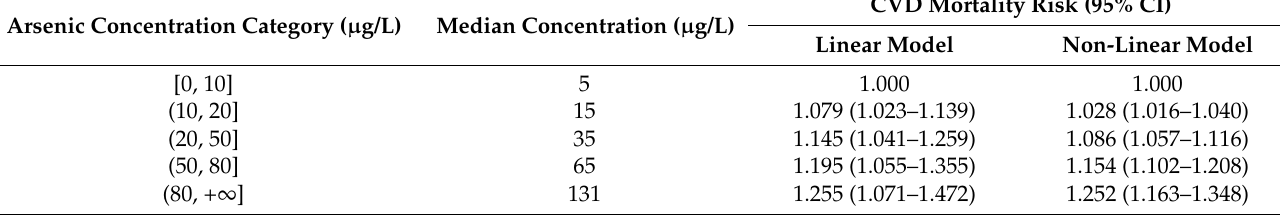
Table 1. Dose–response relationships between cardiovascular disease mortality and arsenic concentration in drinking water. Pooled relative risks (95% CIs) for cardiovascular disease (CVDs) mortality for the median concentration in each arsenic concentration category relative to the median concentration in the reference category of 0–10 µ g/L. Calculations after Xu et al. [24]. Linear model: Coefficient for trend: 0.070; p -value for trend: 0.005; deviance: 22.58; AIC: − 6.77; R 2 : 0.258;